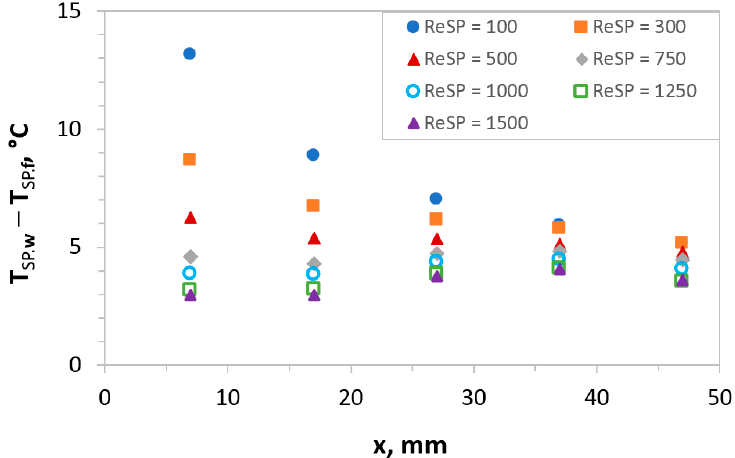
Figure 4. Dependence of the temperature difference between the wall and fluid temperatures along the length of the MFHE channel for a single-phase flow at Re SP = 100–1500.